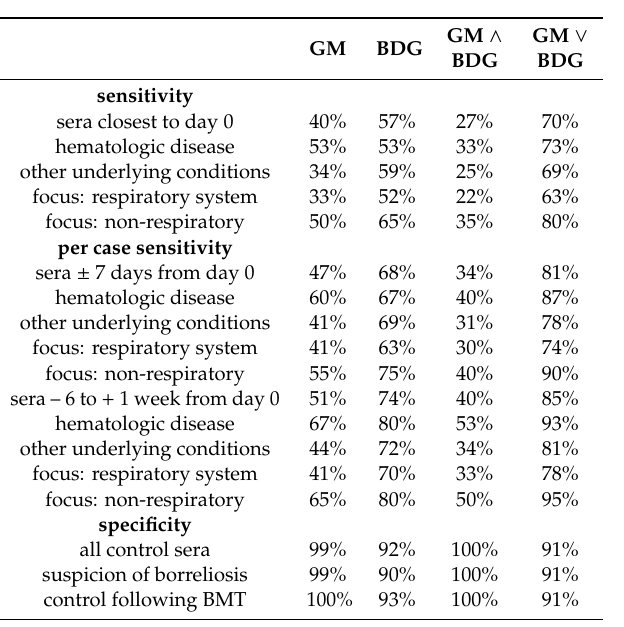
Table 4. Sensitivities and